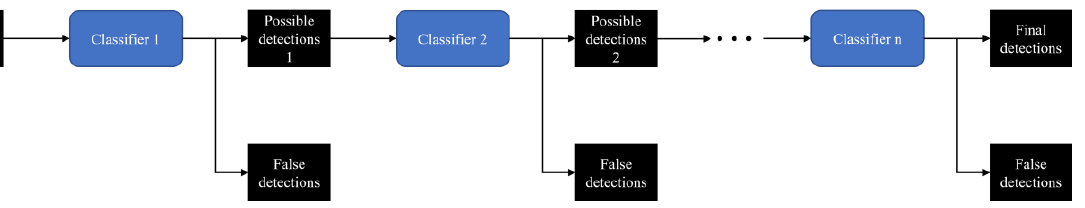
Figure 2. The schematic of the cascade network proposed by Viola and Jones [1].